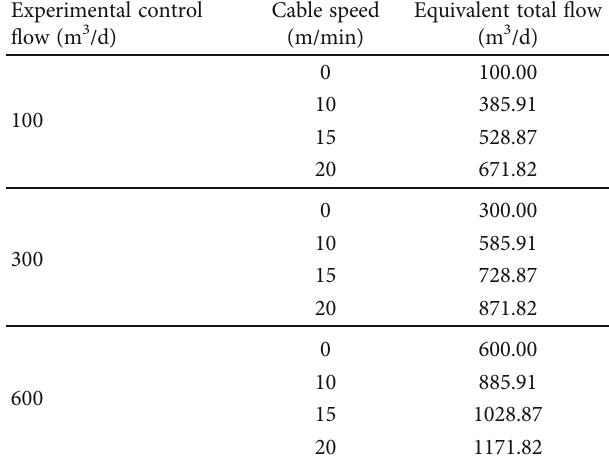
Table 1: Cable speed- fl ow conversion table.